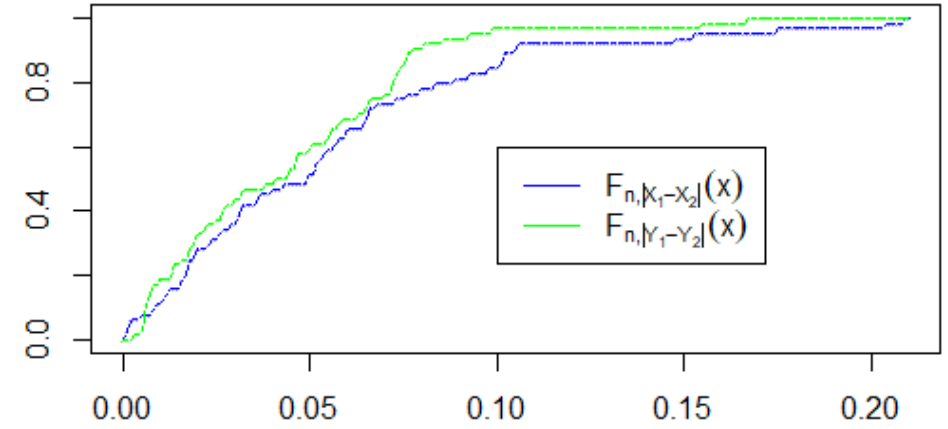
Figure 1. Distribution functions of empirical absolute differences. The green curve corresponds to ( x ) and the blue curve to F F n , | X 1 − X 2 |